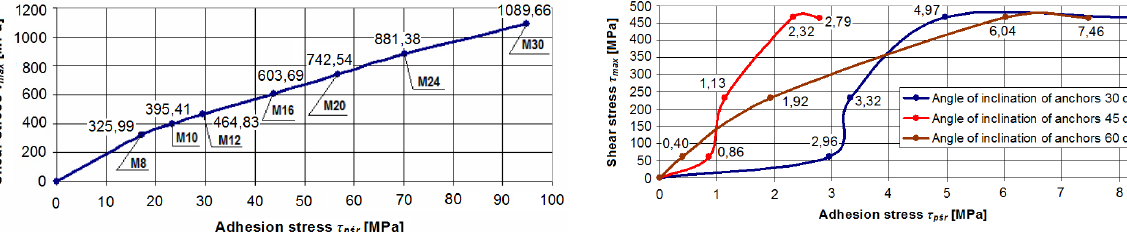
Figure 15: Dependency shear stress – adhesion stress for M8 ÷ M30 anchors in a balcony slab.